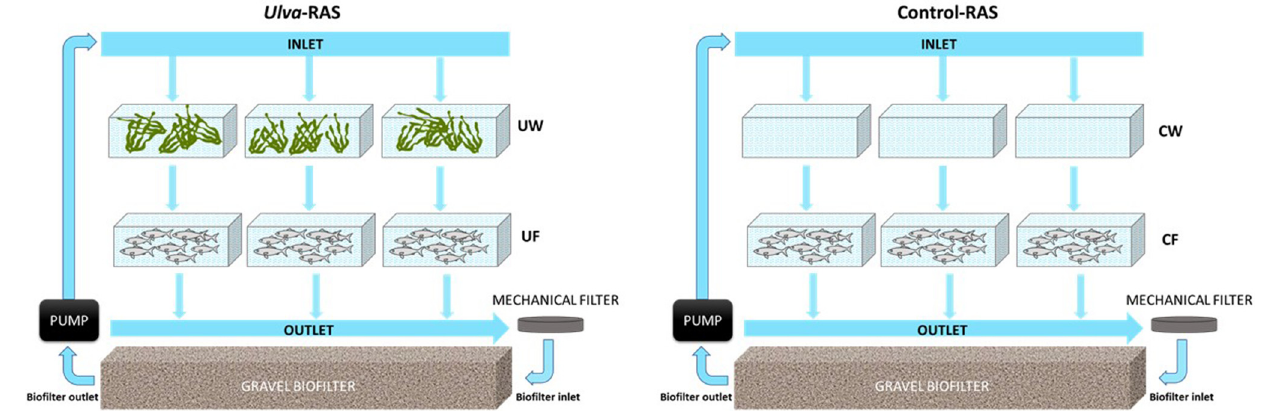
Fig. 1. Experimental design. Ulva -RAS: co-culture of Ulva and seabass with the fi rst in the upper tanks (UW) and the second in the lower tanks (UF). Control-RAS: upper tanks without seaweed (CW) and lower tanks for sea bass rearing (CF), GRAVEL BIOFILTER: a bed of gravel with bacterial bio fi